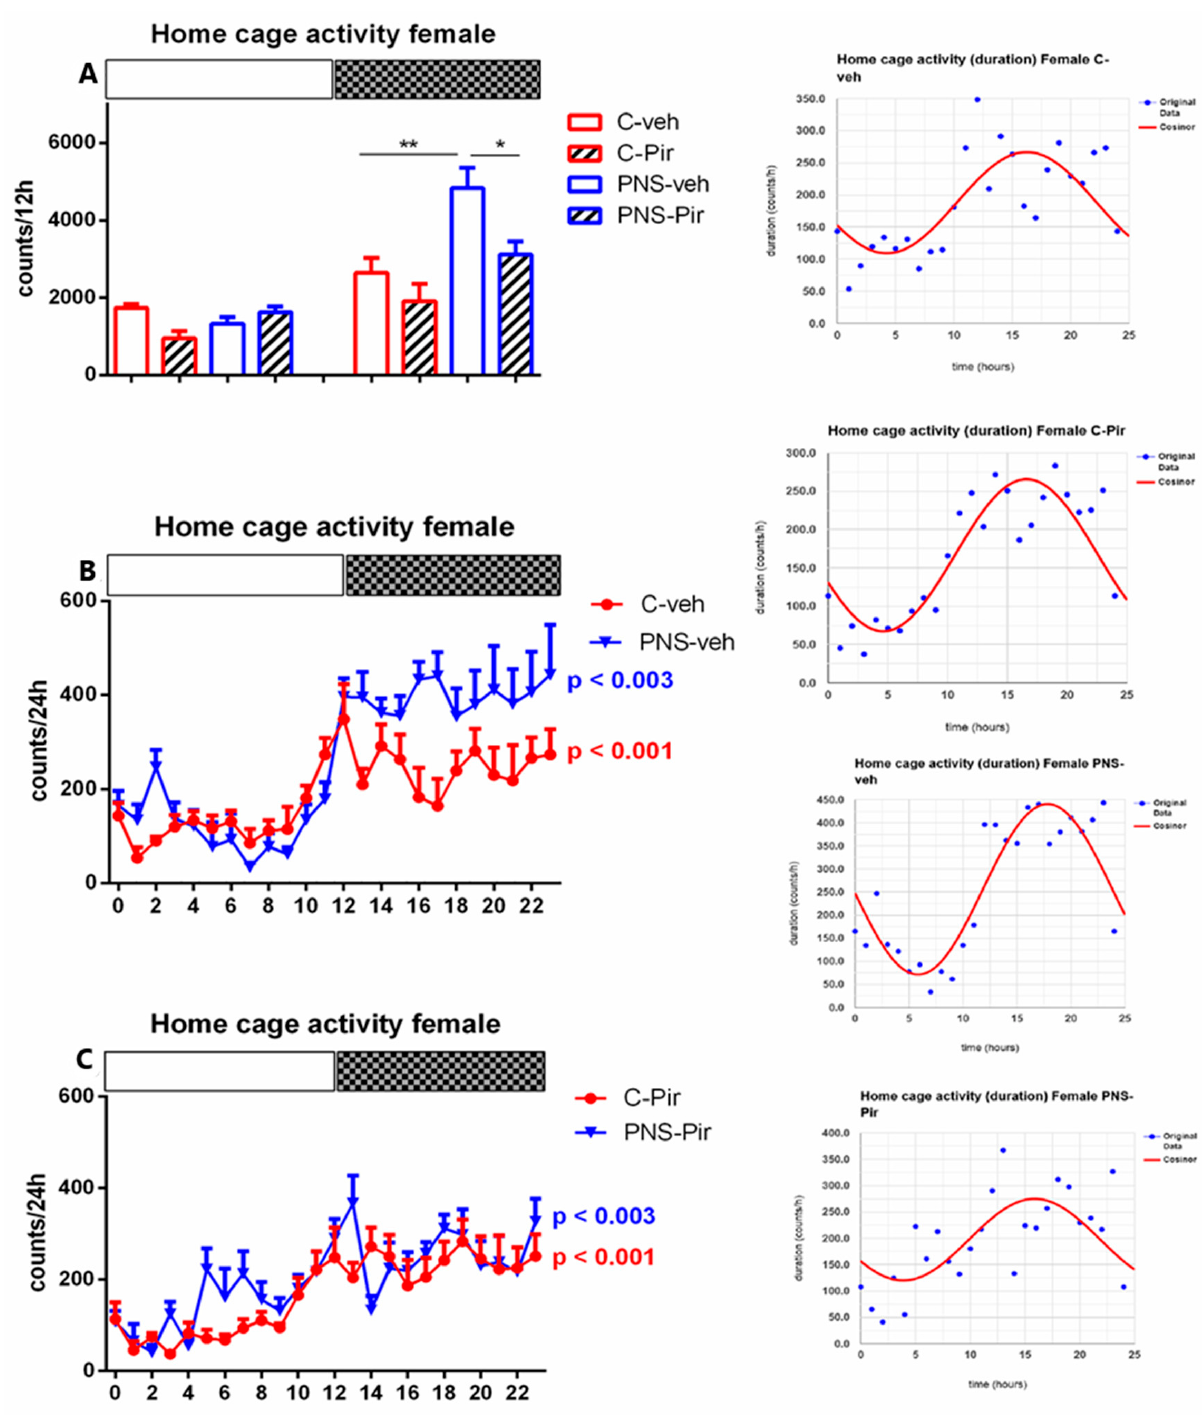
Figure 2. Diurnal variations of home cage activity (total counts) in female rats during the Light and the Dark phase (24-h period registration) for C-veh, C-Pir, PNS-veh and PNS-Pir group ( A ). Light and dark periods are indicated by open and black rectangles above the figure. Data are presented as mean ± SEM, n = 8/group. Circadian distribution of motor activity (counts/h) for C-veh and PNS-veh groups ( B ) and C-Pir and PNS-Pir groups ( C ) over a 24-h recording. Original and cosinor data are shown in the inset on the right. ** p = 0.0047 vs. C-veh (Dark phase); * p = 0.0153 vs. PNS-veh (Dark phase),